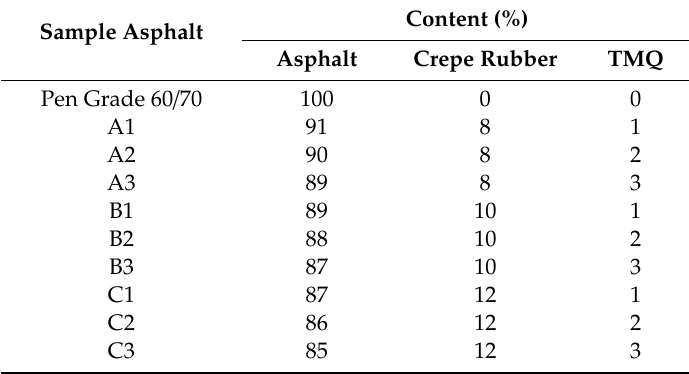
Table 3. Modified asphalt sample